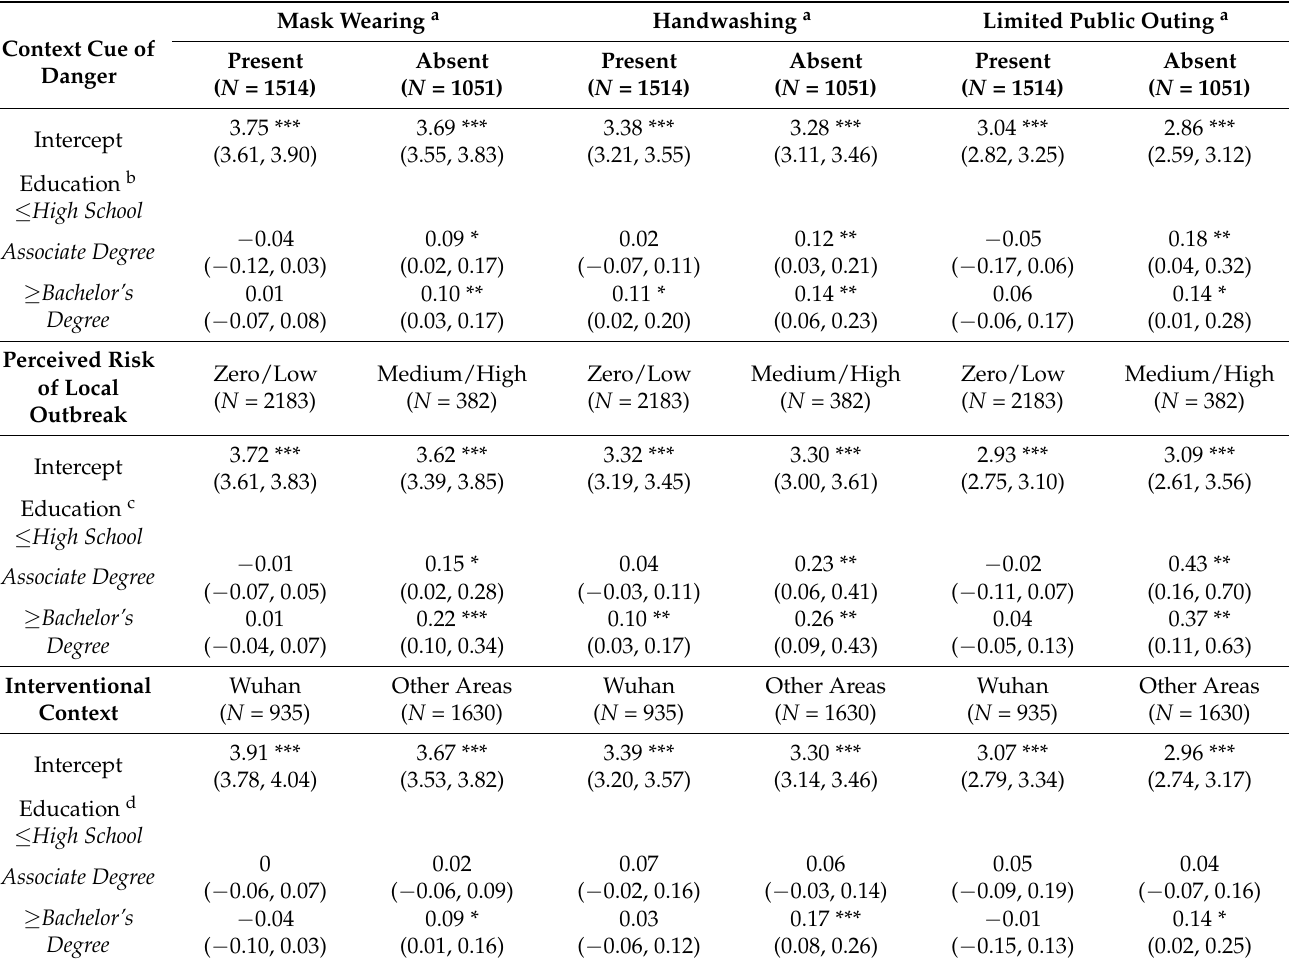
Table 3. Educational Disparities in COVID-19 Preventive Behaviors Stratified by Context Cues of Danger, The Subsample of Urban Residents, The Chinese Survey of COVID-19 Impacts 2020 ( N =